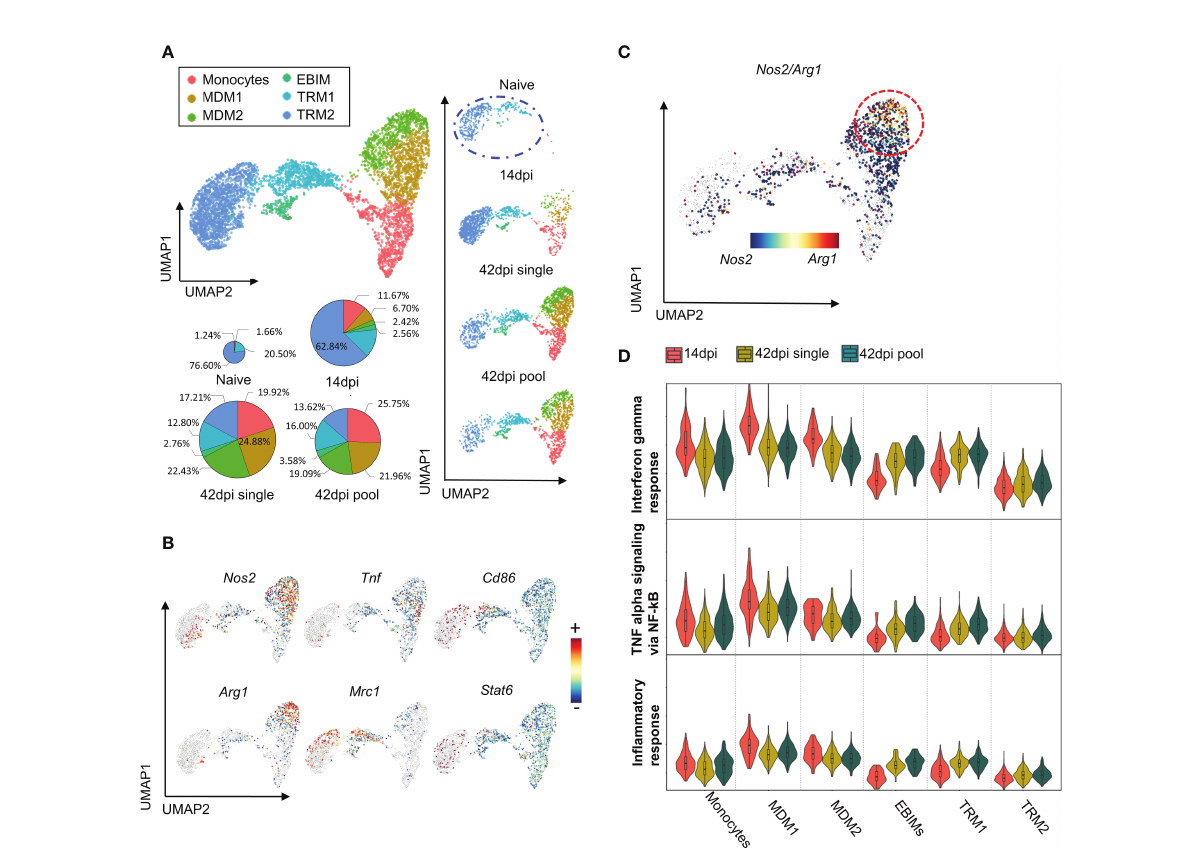
FIGURE 3 scRNA-seq analysis reveals heterogeneity of Macrophages population during early and late stage of T. evansi infection. (A) Uniform Manifold Approximation Projection (UMAP) of Macrophages sub-populations and their portion across 3 time points (pie charts). MDM: Monocytes Derived Macrophages, EBIM: Erythroblast Island Macrophages, TRM: Tissue Resident Macrophages. (B) Log-normalized expression of classical markers for M1 (upper panel) and M2 (lower panel) macrophages on combined Macrophages from 3 time points. (C) Co-expression levels of Nos2/Arg1 genes on 42dpi single and 42dpi pool datasets derived Macrophages. (D) Interferon gamma response score (Top panel), TNF alpha signaling via NF-kB score (Middle panel), and In fl ammation response score (Bottom panel) of Macrophages sub-populations during